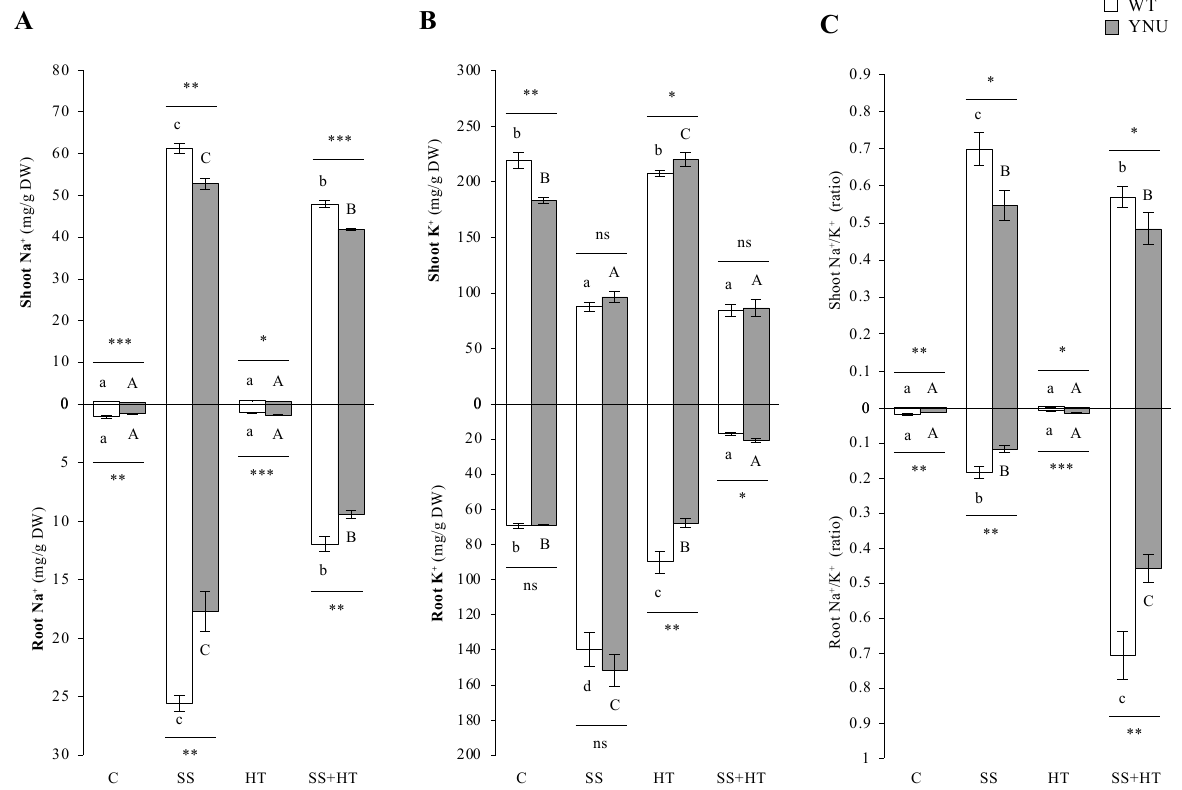
Figure 3. Na + and K + ion content of rice seedlings under salinity (SS), high-temperature (HT), and combined salinity and heat (SS + HT) conditions; ( A ) K + content of shoot (top panel) and root (down panel), ( B ) Na + content of shoot (Top panel) and root (down panel), and ( C ) Na + /K + ratio of shoot (Top panel) and root (down panel) of WT and YNU seedlings under control (C: 26/23 ◦ C, 0 mM NaCl), saline (SS: 26/23 ◦ C, 75 mM NaCl), high-temperature (HT: 30/26 ◦ C, 0 mM NaCl), and combined salinity and heat (SS + HT: 30/26 ◦ C, 75 mM NaCl) conditions. Values represent the means ± SE determined from three independent experiments using four plants in each experiment. Means within the same graph followed by different lowercase (WT) and uppercase (YNU) letters are significantly different at p < 0.05 according to Tukey’s HSD test. Asterisks represent statistical significance of difference using Student’s t -statistic with *** p < 0.001, ** p < 0.01, * p < 0.05, ns: